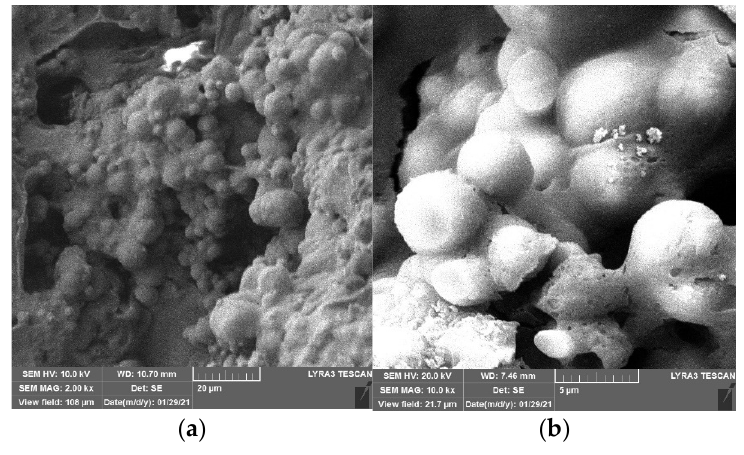
Figure 11. SEM images of CaCO 3 crystals from bottom layer. ( a ) 2 kx. ( b ) 10